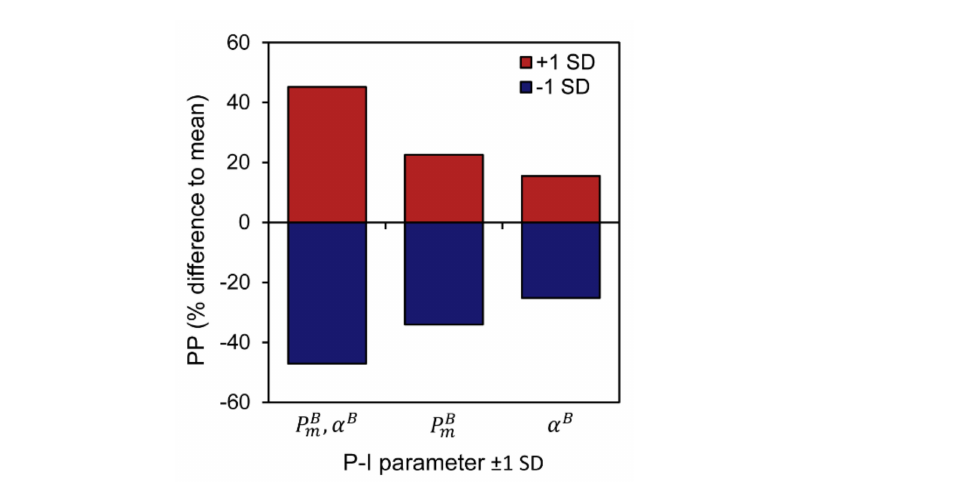
Figure 7. Percentage change in global annual primary production (PP) compared with estimates based on mean photosynthesis versus irradiance (P-I) parameters. Results from three different sensitivity analyses are given: (1) both the initial slope ( α B ) and assimilation number ( P B m ) of the P-I curve were adjusted by ± 1 standard deviation (SD) [ P B m , α B ]; (2) only P B m was adjusted by ± 1 standard deviation [ P B m ]; and (3) only α B was adjusted by ± 1 standard deviation [ α B